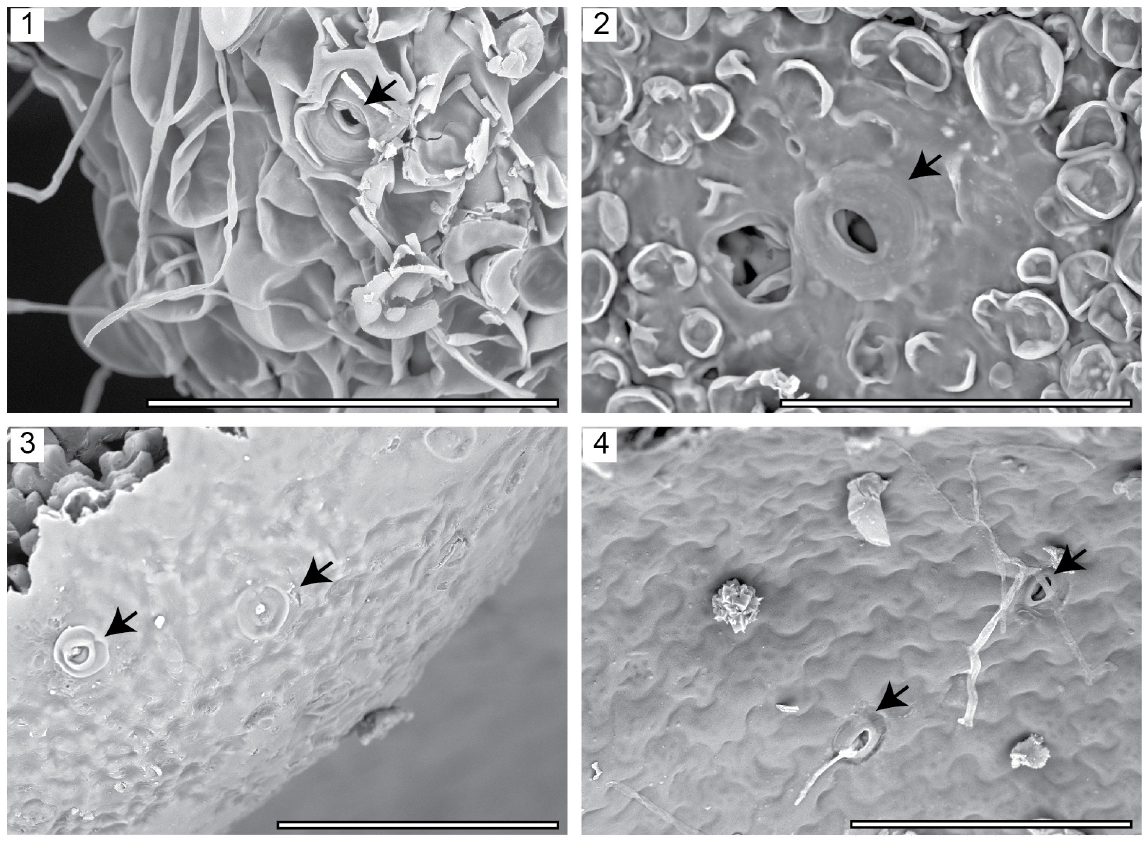
Fig. 37. SEM image of stomata on the locule surface (arrow). 1 . Pyrenacantha malvifolia Engl. ( P. Polill 475 ). 2 . Rhyticaryum macrocarpum Becc. ( W. Vink 11381 ). 3 . Stachyanthus donisii (Boutique) Boutique . 4 . Stachyanthus occidentalis (Keay & É.Miège) Boutique ( J.H. Laurent 42 3). Images taken from Del Rio (2018). Scale bars: 100